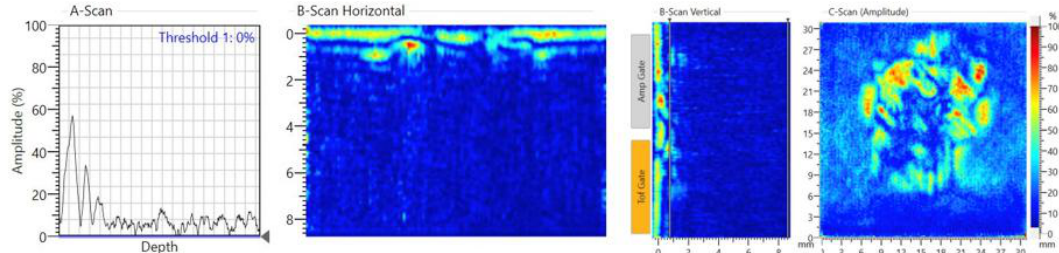
Figure 14. Non-destructive test (NDT) result after impact. Figure 14. Non ‐ destructive test (NDT) result after impact.